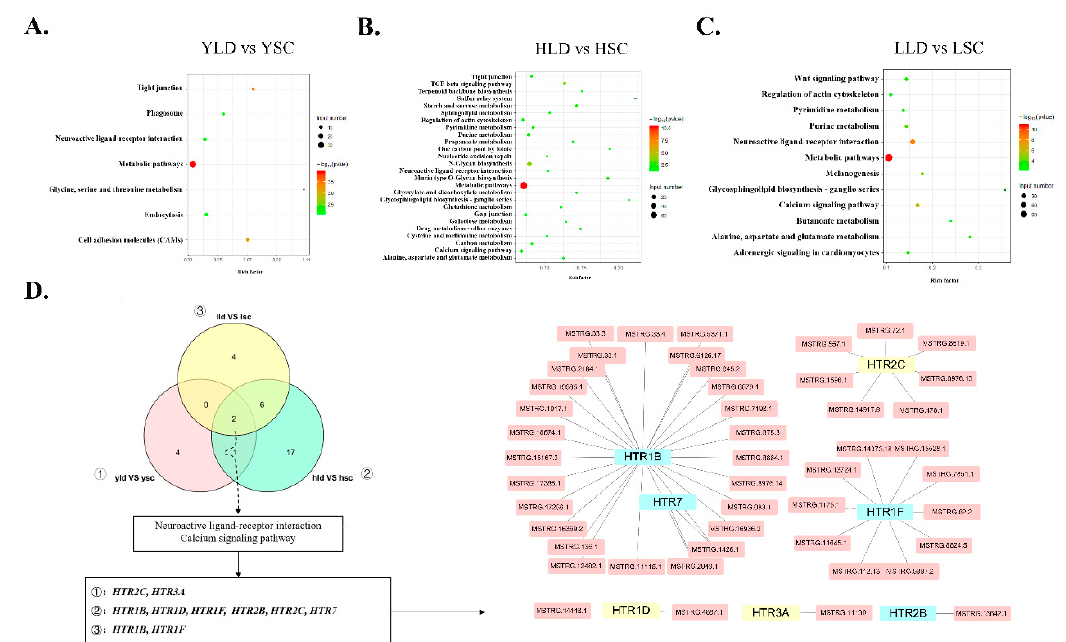
Figure 4. KEGG pathways enriched in the DE lncRNAs between the breeds. The KEGG pathways enriched in the DE lncRNAs between YLD vs. YSC ( A ), HLD vs. HSC ( B ), and LLD vs. LSC ( C ). ( D ) The neuroactive ligand–receptor interaction pathway and calcium signaling pathway overlapped in the three groups. Target genes belonging to the HTR family in each group are listed separately. HTR1B, HTR2B, HTR1F, and HTR7 were differentially expressed in at least one group (blue module), and HTR2C, HTR1D, and HTR3A were not differentially expressed in each group (yellow module). The DE lncRNAs are represented by pink ellipses.